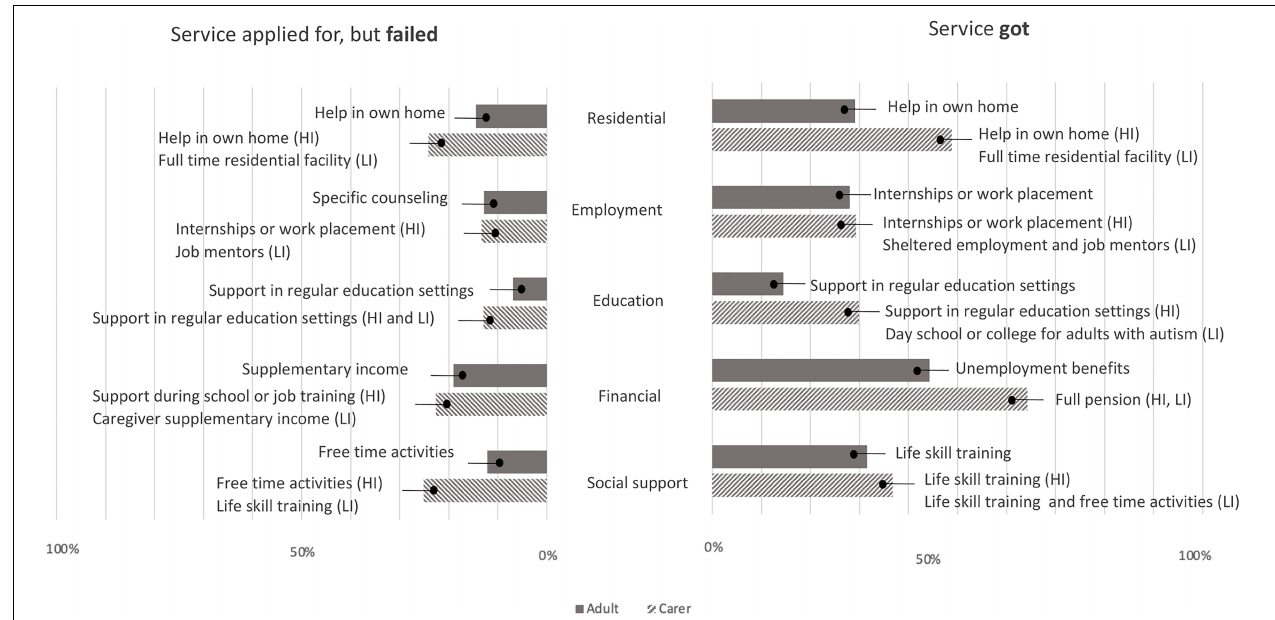
FIGURE 1 | Services that had been applied for but failed to get or Services got reported by autistic adults and carers. Values expressed as percentages. Shown in the text boxes are the most frequently selected specific service option within each service area reported by autistic adults and carers of high independent adults (HI) and low independence adults